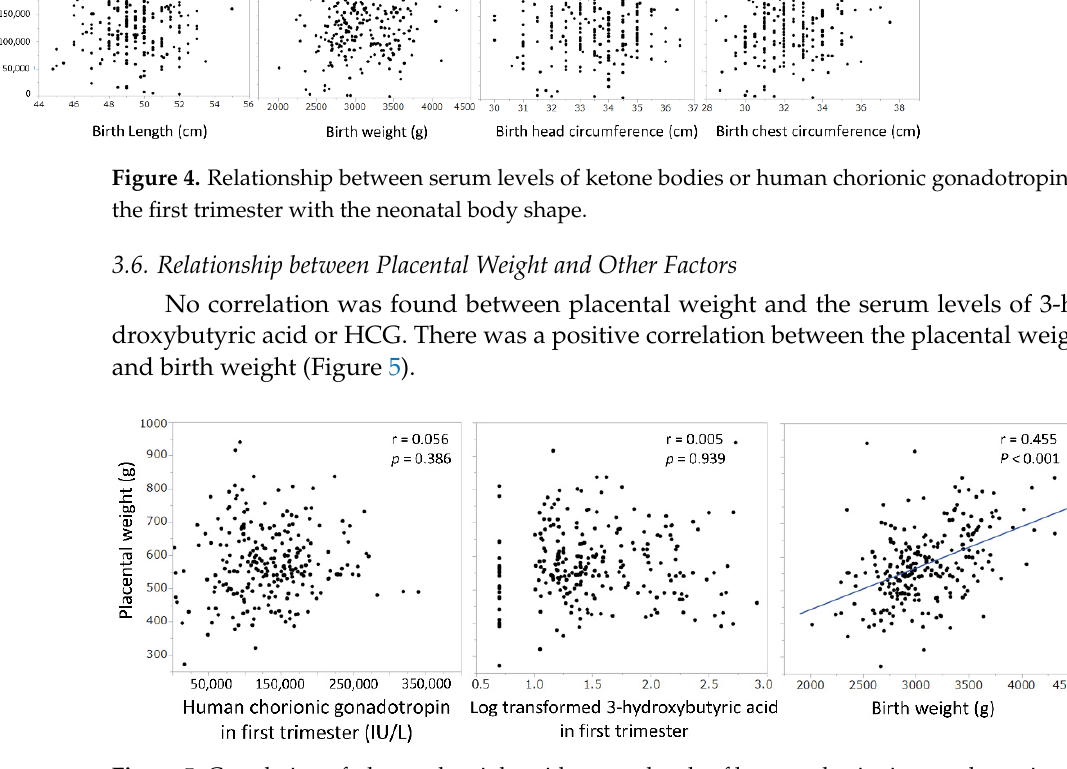
Figure 4. Relationship between serum levels of ketone bodies or human chorionic gonadotropin in the first trimester with the neonatal body shape.